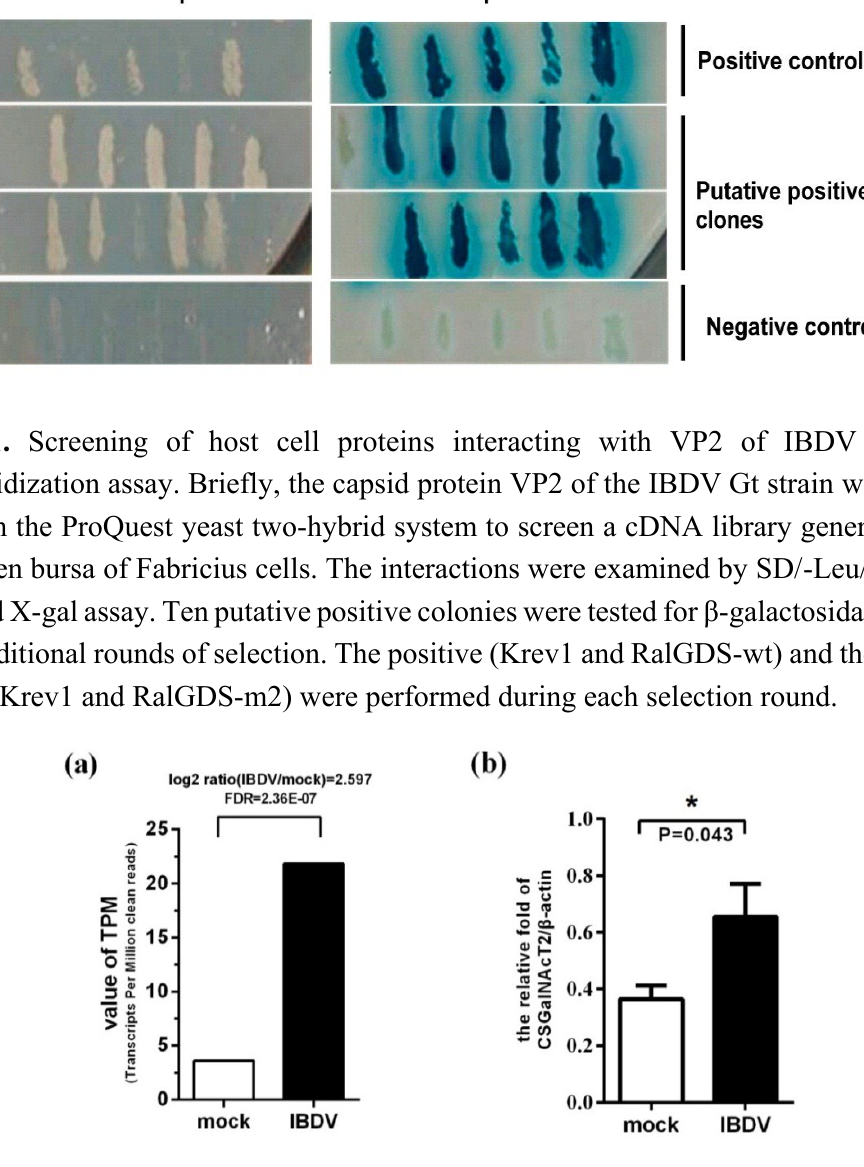
Figure 2. CSGalNAcT2 is up-regulated during IBDV infection. ( a ) Differential gene expression analysis by gene chip assay. The total RNA of CEF cells infected by IBDV Gt strain at 24 h post-infection was extracted for gene chip analysis. The value of transcripts per million clean reads (TPM) of CSGalNAcT2 showed that CSGalNAcT2 was up-regulated after IBDV infection. We set the false discovery rates (FDR) < 0.001 and | log 2 ration (IBDV/mock) | > 1 as significantly different differentially expressed genes. ( b ) Detection of CSGalNAcT2 expression by real-time RT-PCR. Real-time RT-PCR was performed to detect the CSGalNAcT2 expression of CEF cells at 24 h post-infection with IBDV Gt strain. Levels of CSGalNAcT2 were normalized to that of beta-actin, which further confirmed the results of gene chip analysis. The results are representative of three independent experiments. Values are the mean ± SEM from three triplicate wells. * , p < 0.05 means significantly